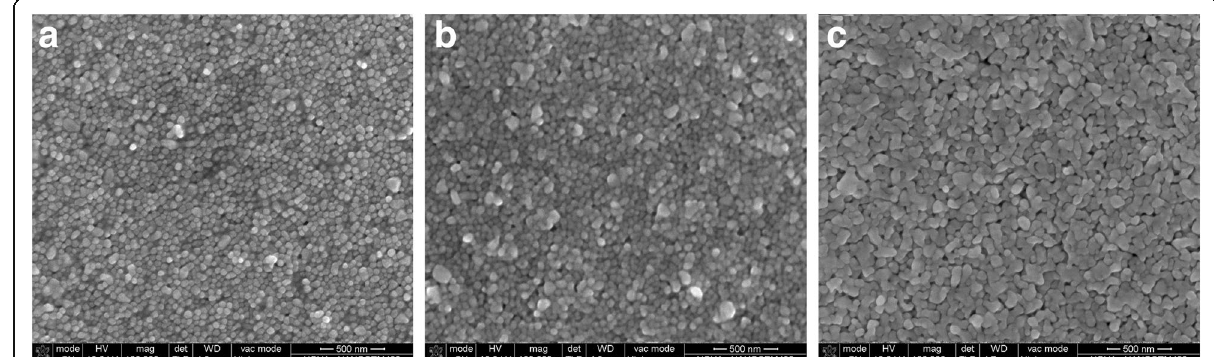
Fig. 8 SEM images of the silver films heat-treated at different temperatures for 30 min: ( a ) 25 °C; ( b ) 100 °C; ( c ) 140